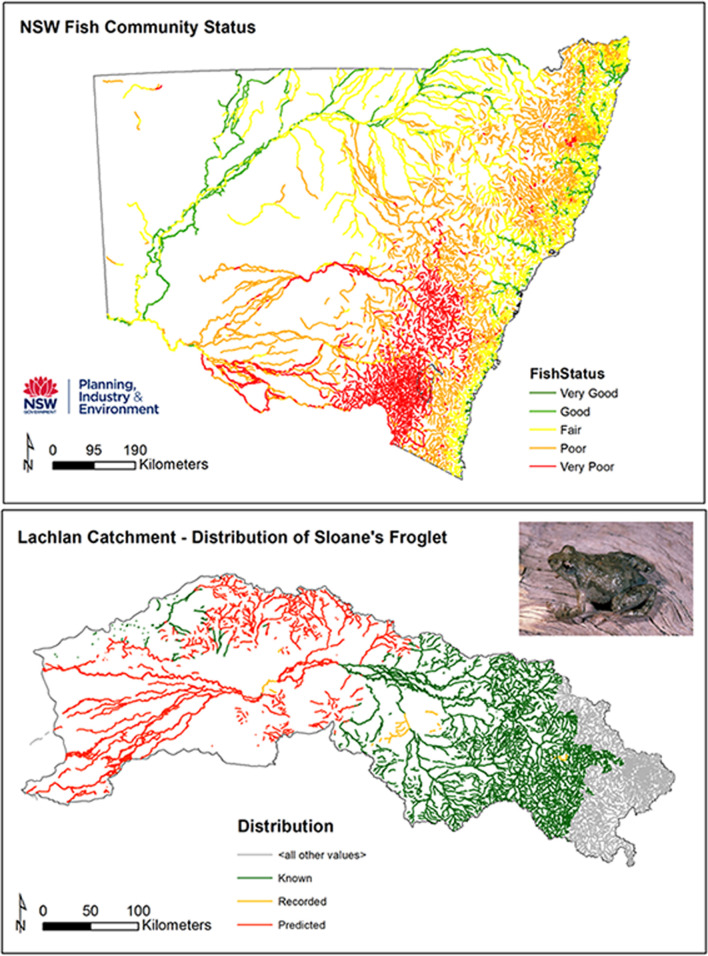
Linking geomorphic river type to general fish community status derived from condition indicators of expectedness, nativeness and recruitment and indicative threatened fish distribution and threatened frog species.Source of photograph: Sloane’s Froglet from Peter Robertson at grasslands.ecolinc.vic.edu.au.